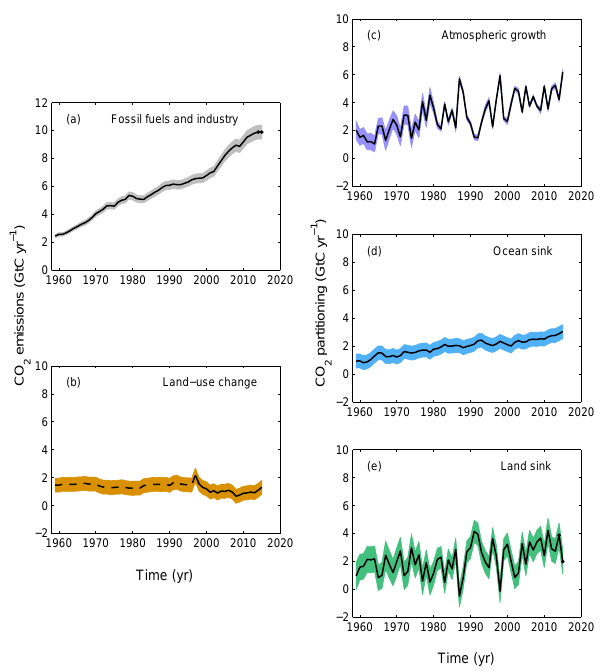
Figure 4. Components of the global carbon budget and their uncer- tainties as a function of time, presented individually for (a) emis- sions from fossil fuels and industry ( E FF ), (b) emissions from land- use change ( E LUC ), (c) growth rate in atmospheric CO 2 concentra- tion ( G ATM ), (d) the ocean CO 2 sink ( S OCEAN ; positive indicates a flux from the atmosphere to the ocean), and (e) the land CO 2 sink ( S LAND ; positive indicates a flux from the atmosphere to the land). All time series are in GtCyr − 1 with the uncertainty bounds repre- senting ± 1 σ in shaded colour. Data sources are as in Fig. 3. The black dots in (a, e) show values for 2014 and 2015 that originate from a different data set to the remainder of the data, while the dashed line in (b) highlights the start of satellite data use to esti- mate the interannual variability and extend the series in time (see